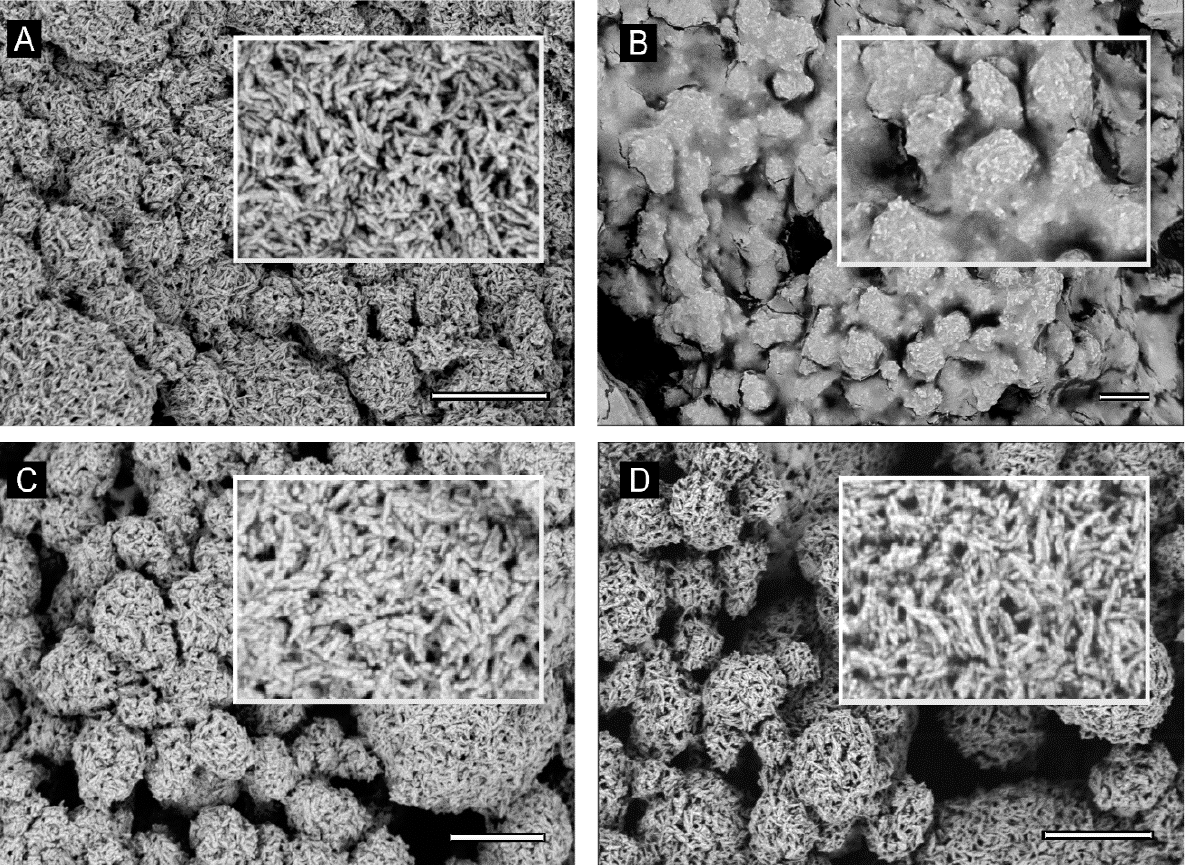
Figure 4. SEM image of HA 80,000x ( A ), HA + C20 35,000x ( B ), HA-Xcc ϕ 1 68,000x ( C ), and HA-Xcc ϕ 1+C20 75,000x ( D ). Scale bar is 1 µm.